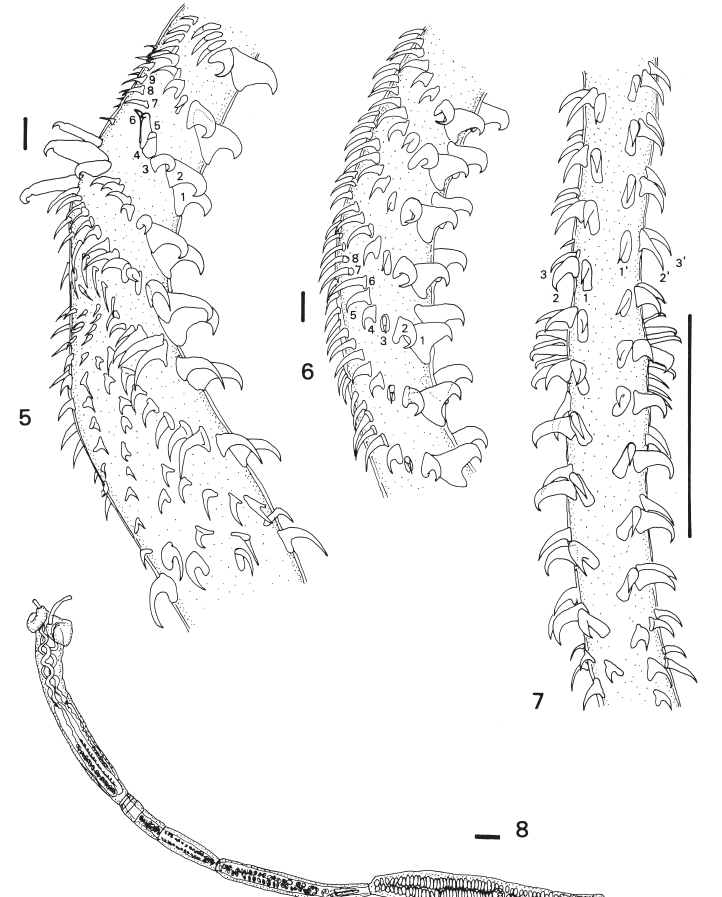
Figs 5-8. – Pseudochristianella elegantissima sp. nov. from Dasyatis brevis (armature) and D. longus (Dasya- tididae) (entire cestode). Fig. 5. Tentacle, antibothrial surface, basal and metabasal armature. Fig. 6. Tentacle, antibothrial surface, internal surface on right hand side, metabasal armature. Fig. 7. Tentacle, internal sur- face, bothrial surface on right hand side, basal and metabasal armature. Fig. 8. Entire cestode. Scale-lines: Figs 5,6, 0.01 mm; Figs 7,8, 0.1